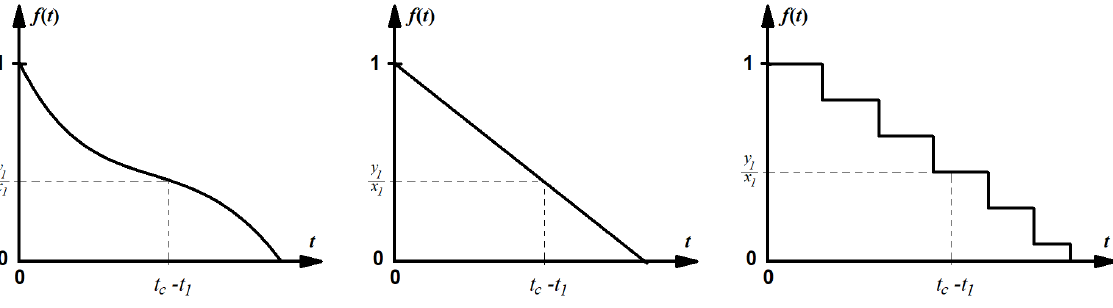
Figure 7. Examples of the waveforms of the CCE account value limiting function f ( t ): continuous degressive, linear, gradual degressive.